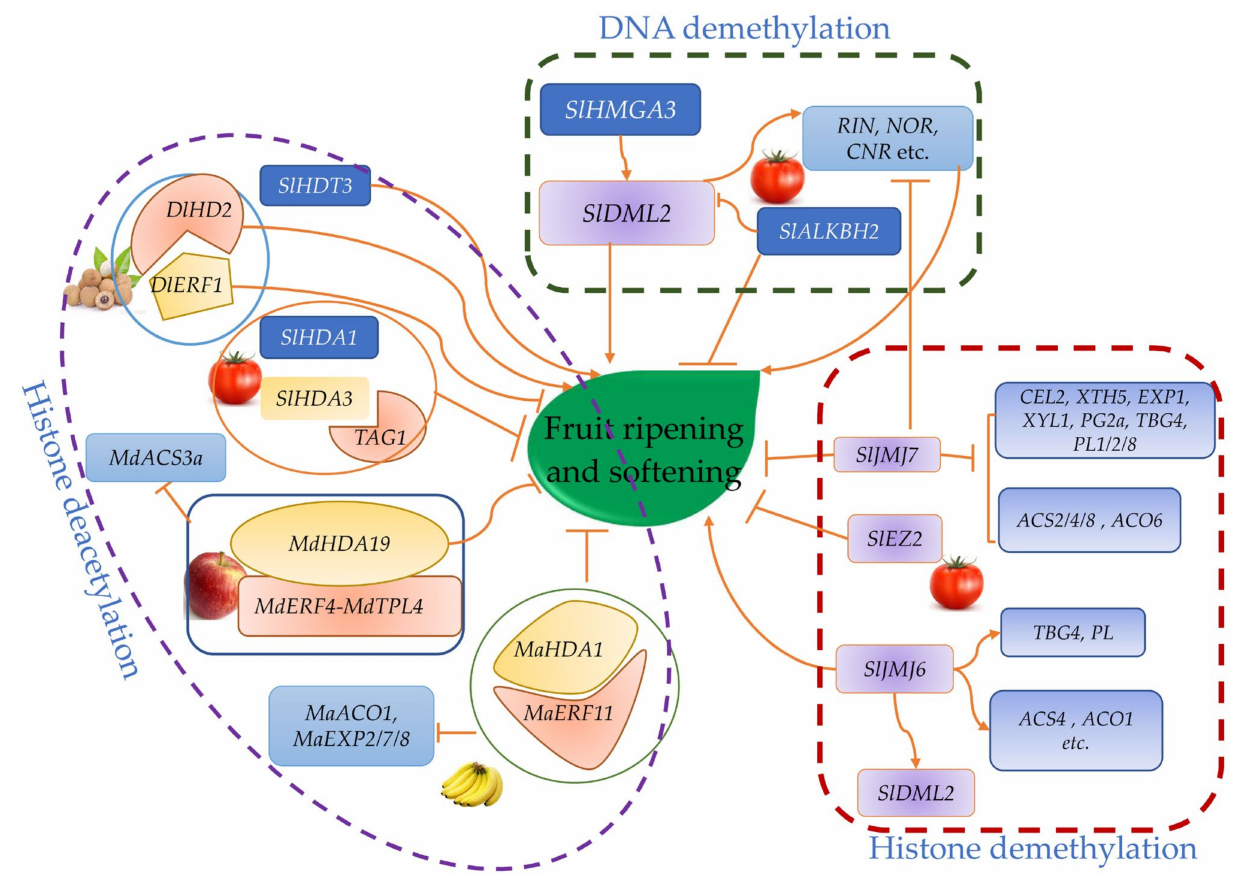
Figure 3. Role of epigenetic modifications in ripening and softening of fleshy fruits. The arrows indicate activation, whereas arrows with blunt ends indicate inhibition (see